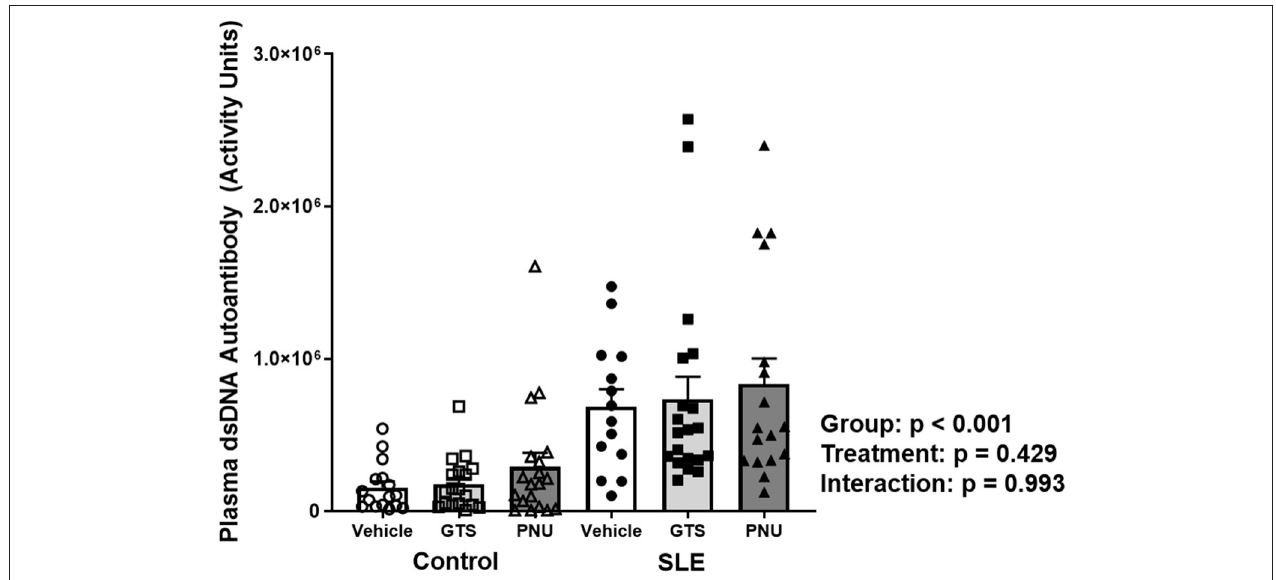
FIGURE 1 | Plasma levels of dsDNA autoantibodies (activity units) in control and SLE mice treated with either vehicle, GTS-21, or PNU-120596. Neither GTS-21 nor PNU-120596 had a significant effect on albumin excretion rate in control or SLE mice ( n = 14–20 per group). Data were analyzed using a two-way ANOVA and the results of this analysis are listed on the graph.